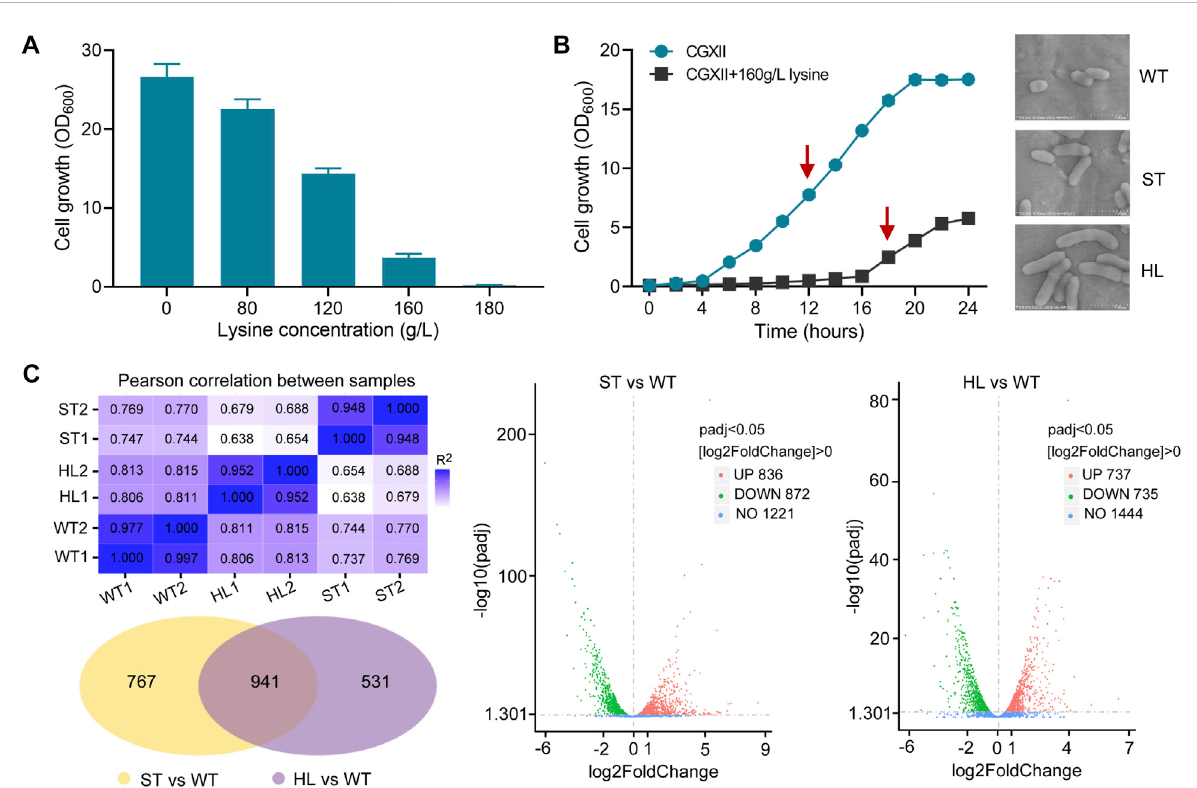
FIGURE 1 Growth assay and RNA-seq analysis of C. glutamicum in response to lysine challenges. (A) Growth of C. glutamicum cells in CGXII minimum medium with different concentrations of L -lysine. Cells were inoculated into 100 ml fl asks containing 20 ml of medium for 20 h at 32 ° C. (B) Growth curves and morphological features of C. glutamicum strain with and without L -lysine stress. The growth experiments were carried out in 250 ml fl asks containing 100 ml of CGXII medium at 30 ° C. The arrows indicate time points for RNA harvest at the midexponential growth phase. Scanning electron microscopy (SEM) was used to examine the cell morphology of the WT, ST, and HL samples. (C) An overview of transcriptome analysis among different lysine-treated samples. Venn diagram and Volcano plots were used for visualization of differentially expressed genes (DEGs). “ WT ” represents non-lysine-treated samples, while “ HL ” indicates cells that suffered from a constant challenge of 160 g/L lysine. “ ST ” represents the midexponential samples subjected to 160 g/L lysine for 1